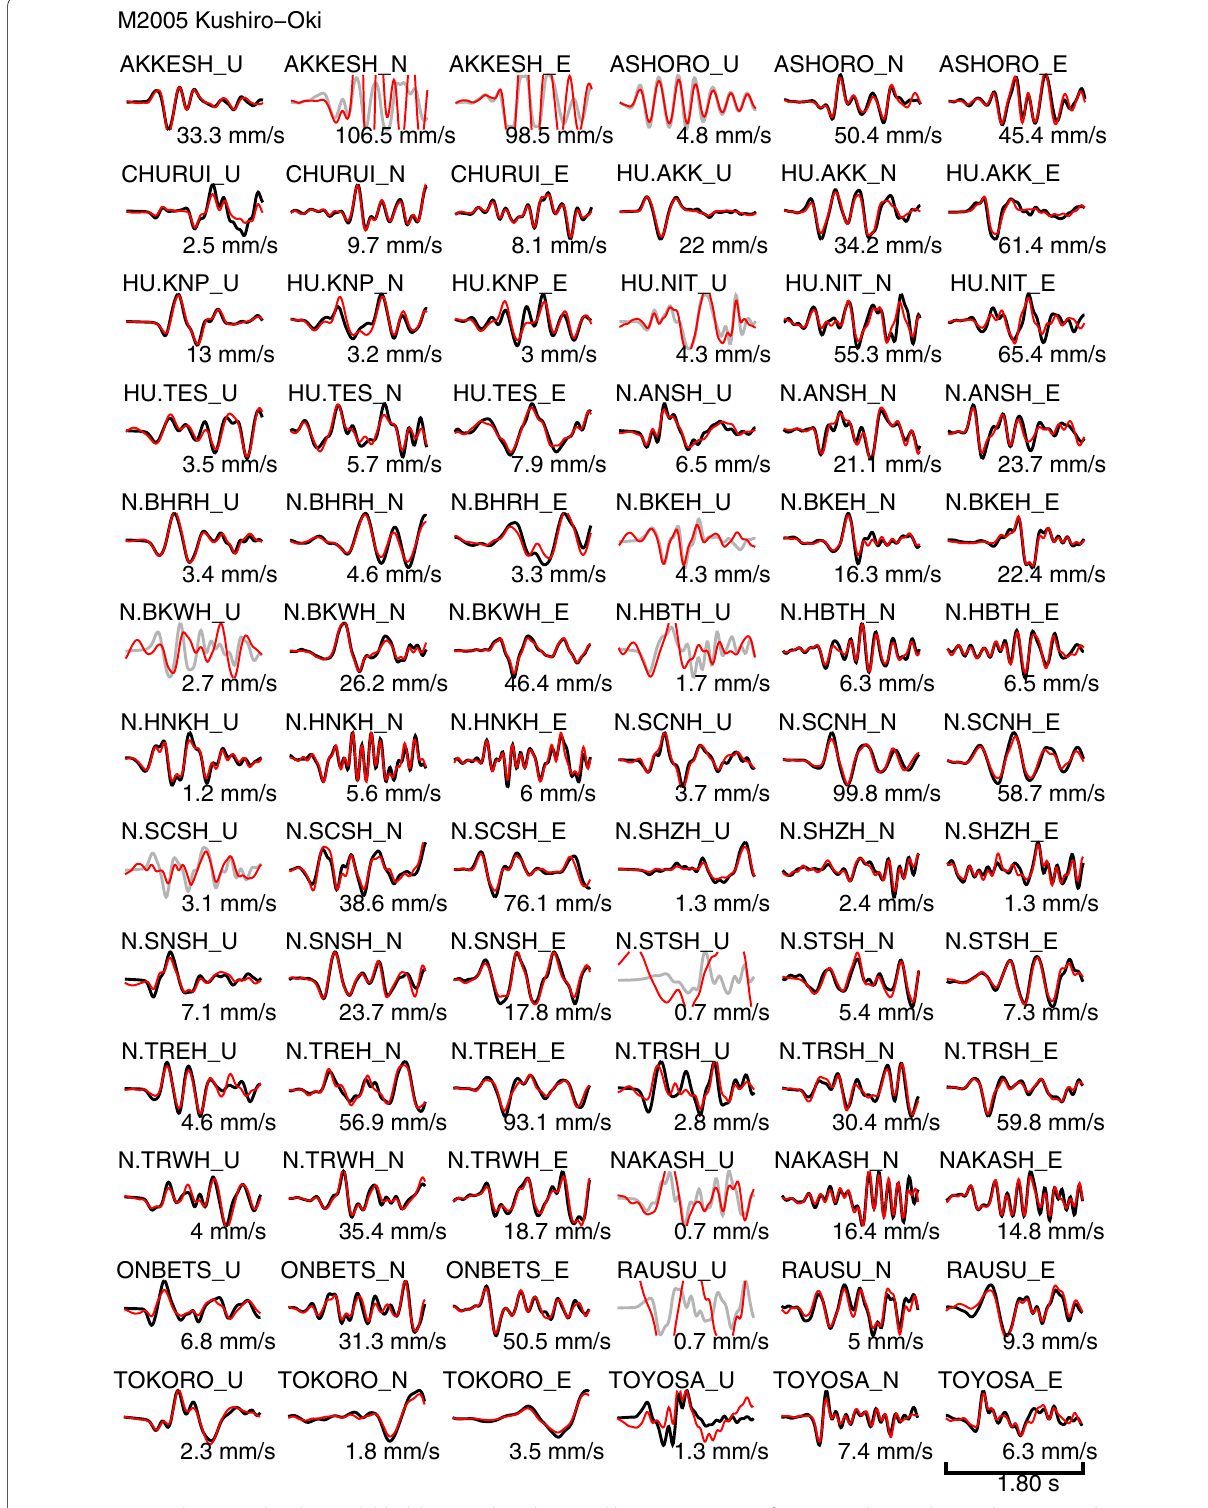
Fig. 4 Comparison between the observed (black lines) and synthetic (red lines) seismograms for M2005. The gray lines indicate unused (noisy) data. Each set of traces is normalized by the maximum value of the observed seismograms, which is listed at the bottom of each